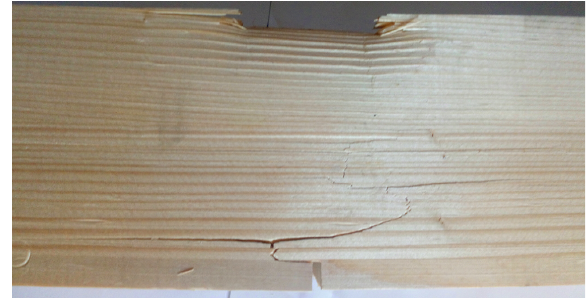
Figure 15. Back face of the beam #11.